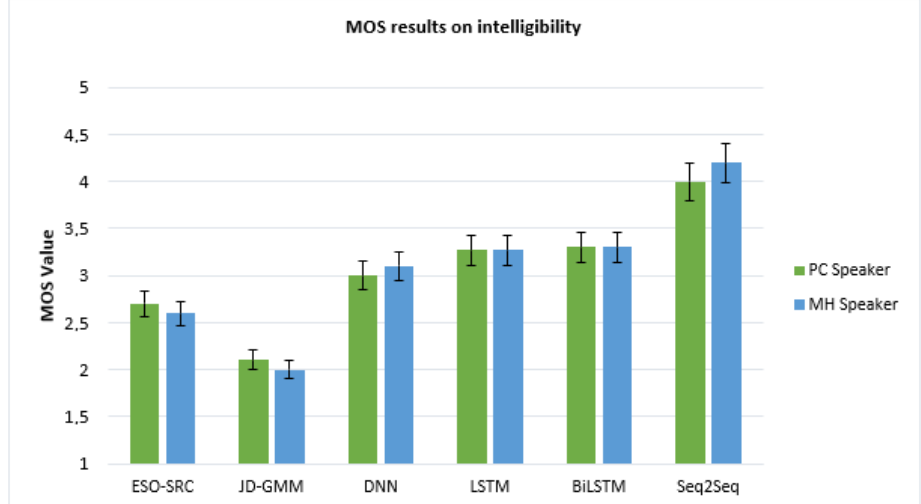
Figure 5. MOS on intelligibility test results with 95% confidence